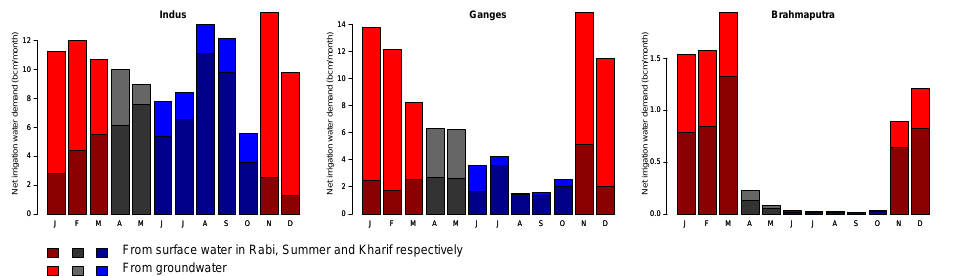
Figure 7. Monthly net irrigation-water demand for three river basins. Colours indicate the different seasons (red – kharif, grey – summer, blue – rabi) and the dark areas the source for supplying the irrigation water (dark – surface water, light – groundwater).